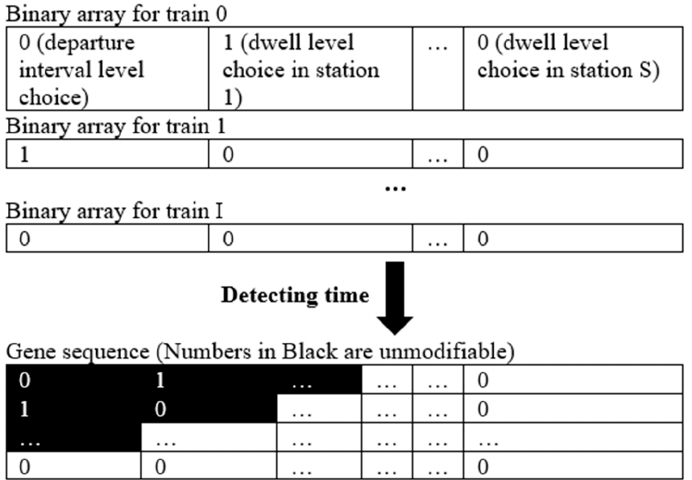
Figure 3. Approach to generate gene sequence for GA_RPOM.